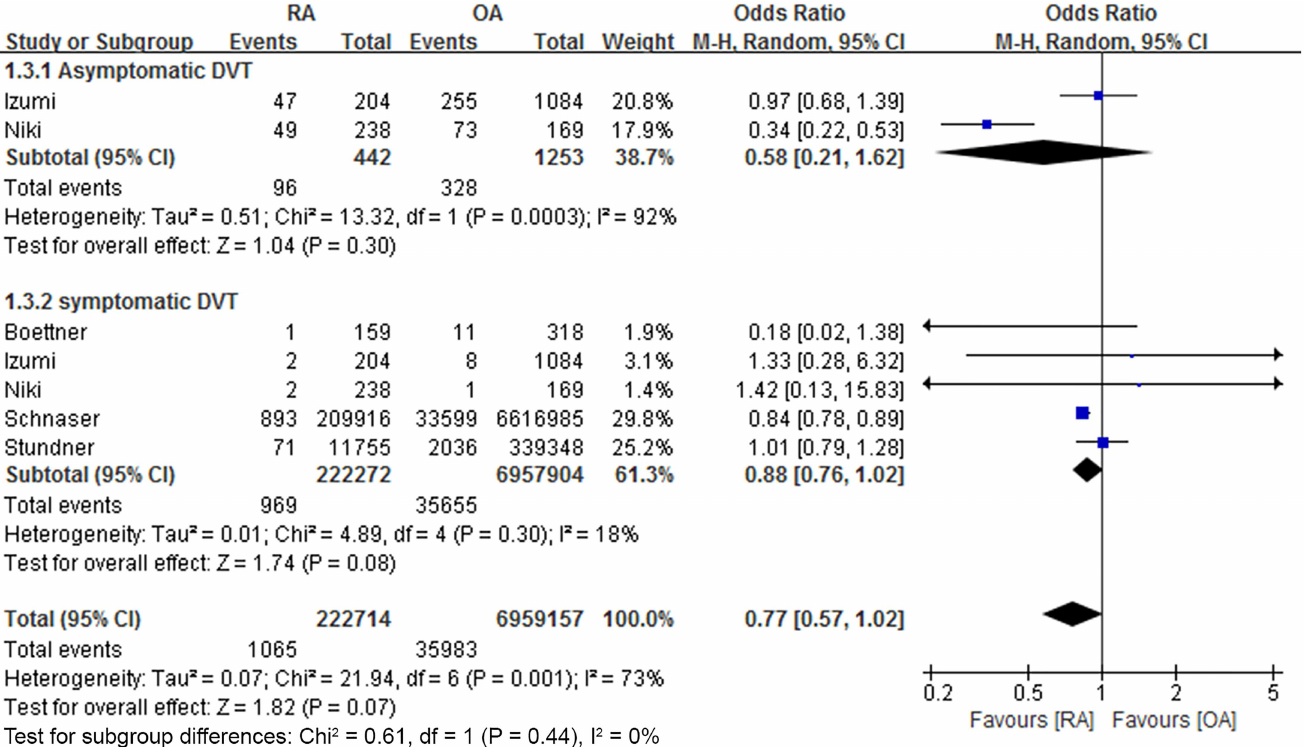
Fig 2. Forest plot showing differences in the rate of deep vein thrombosis after total knee arthroplasty between patients with rheumatoid arthritis (RA) and osteoarthritis